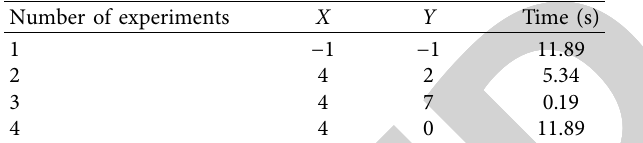
Table 3: By setting different step lengths and different iteration times the experimental